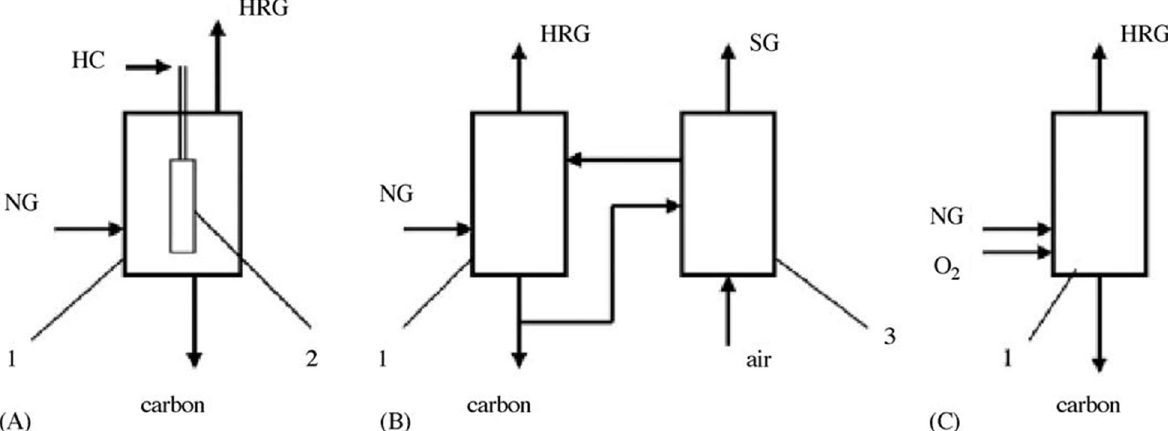
Figure 5. Internal ( A ), external ( B ), and thermoneutral ( C ) are the three options for heat input (C). For the heat input necessary for CH 4 breakdown, there are three options. Exhaust gases, heat transfer medium, and hydrogen-rich gas (NG HRG) are all used. Methane breakdown reactor, reactor heating, and catalyst particle heating are the three components (License Number: 5411970124733) [88].